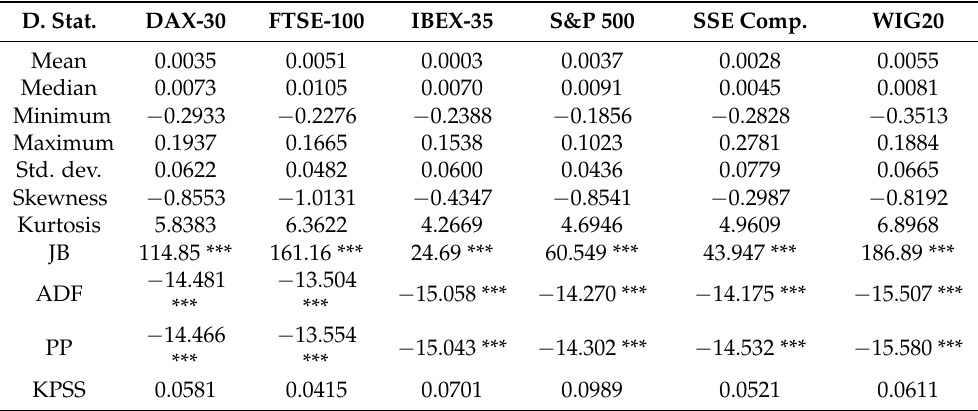
Table 1. Main descriptive statistics for monthly log-returns of international stock markets from January 1998 to December